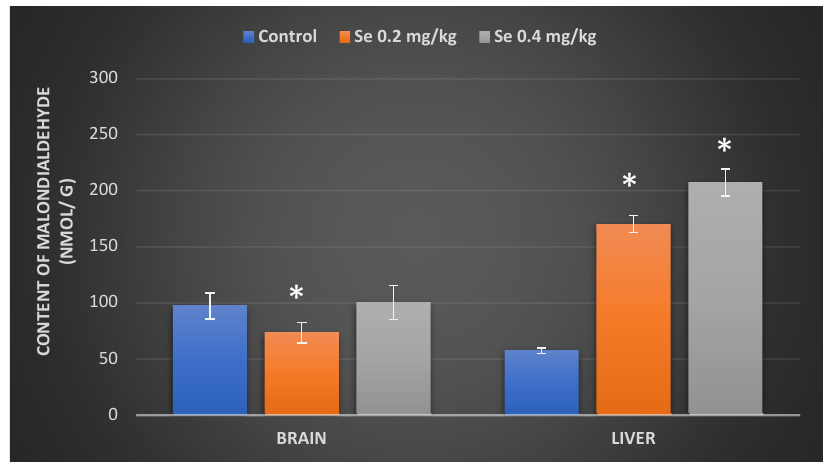
Figure 3. Content of malondialdehyde in mice brain and liver of the control group mice and mice orally treated with a Na 2 SeO 3 solution for 8 weeks. The model of selenium exposure to mice is described in the Methods section. Data represent the results of eight separate experiments. Results are expressed as the mean ± SEM. *—differences are statistically significant in comparison to the control group; p < 0.05.